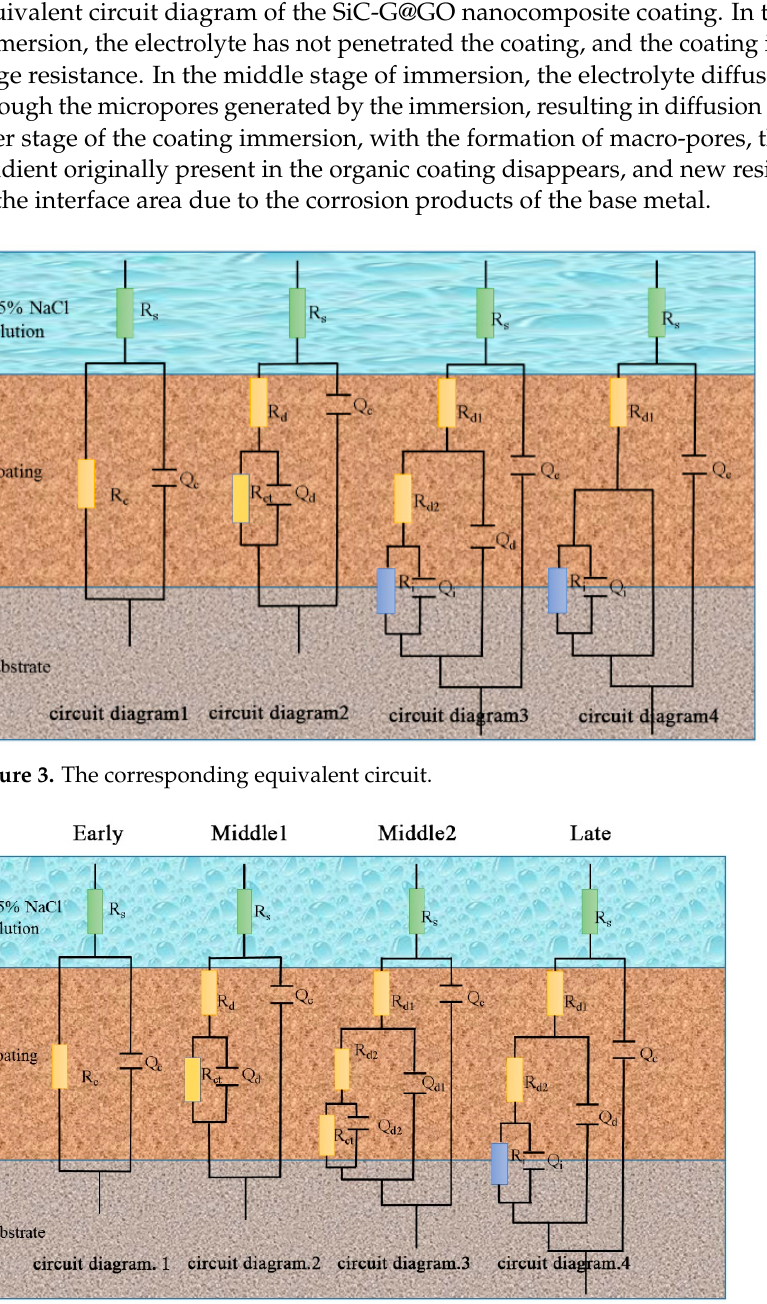
Figure 4. Equivalent circuit diagrams of SiC-G@GO nanocomposite coatings with different ratios.